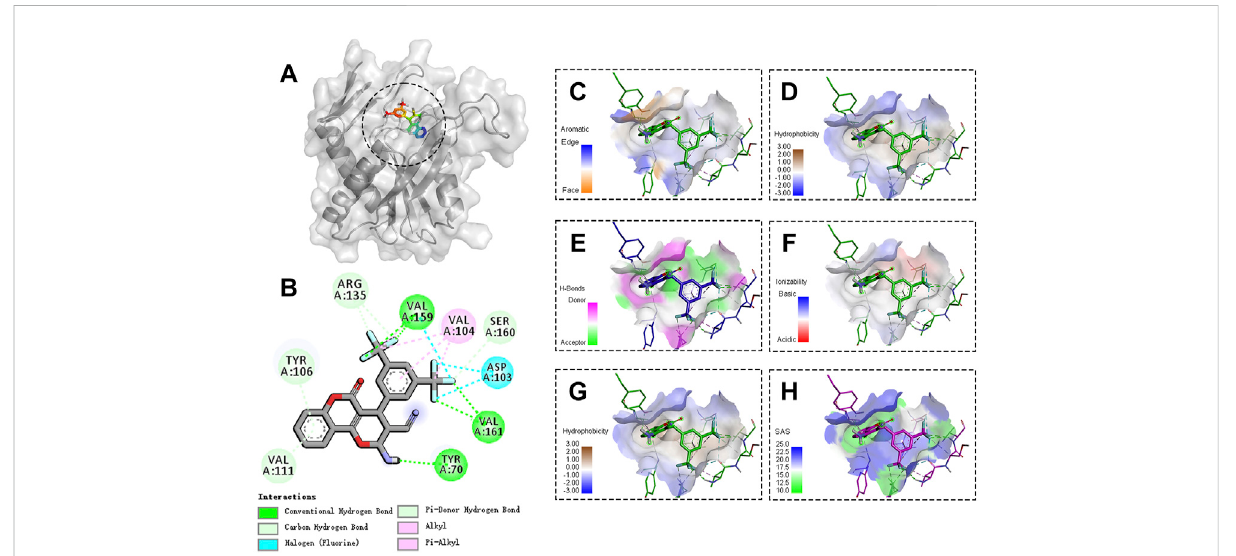
FIGURE 4 BindingsiteandmodelofLP4Cwith PyrR.Overviewofthedockedposebetween theLP4Candbindingpocket totheactivesiteofPyrR (A) .The closeviewoftheinteractionbetweenLP4CandtheactivesiteofPyrR (B) .Theanalyzedresultofthearomaticringedgesorfaces (C) ,hydrophobicity (D) , hydrogen bond (E) and ionizability (F) . The analyzed result of the atomic charge, values less than -0.1 are mapped in red, and values larger than +0.1aremappedinblue (G) .Theanalyzedresultofthesolventaccessibilitysurface,smallvalues(green)correspondtoburiedresidues,whereas large values (blue) correspond to exposed residues (H) .